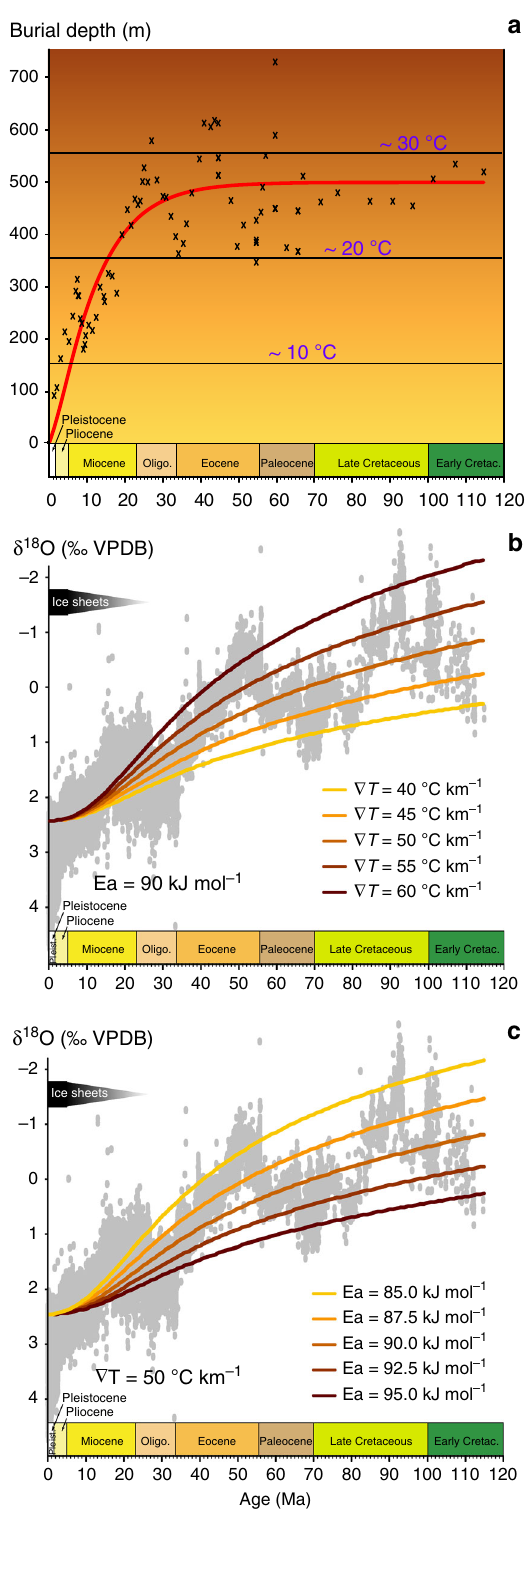
Fig. 3 Assessment of the impact of burial-induced isotope re-equilibration on the benthic foraminifera O isotope record. a Five-point moving average of the burial depths at the DSDP – ODP – IODP sites from which the most comprehensive O isotope compilation is principally derived 9 . The red line indicates the depth pro fi le used for the numerical simulations. The corresponding sediment temperatures are indicated in purple. b , c The benthic foraminifera O isotope compilation from Friedrich et al. 9 (grey) is shown with the results from numerical simulations run with a diffusion activation energy of 90 kJ mol − 1 and a range of geothermal gradients in b , and with a geothermal gradient of 50 °C km − 1 and a range of